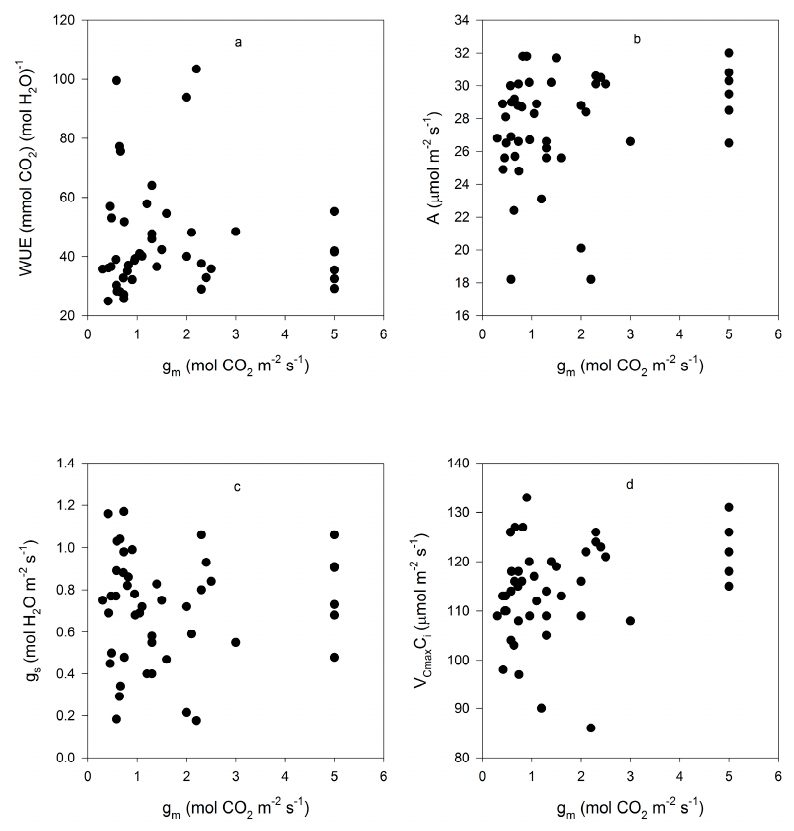
Figure 3. Correlations between g m and ( a ) leaf intrinsic water use efficiency (WUE); ( b ) CO 2 assimilation rate (A); ( c ) stomatal conductance (g s ); ( d ) and the maximum rate of rubisco carboxylation based on C i (V Cmax C i ) for all measurements made on fifteen cultivars of soybean. Correlation coefficients were not significant at p = 0.05, and are given in the text. Plants 2016 , 5 , 44